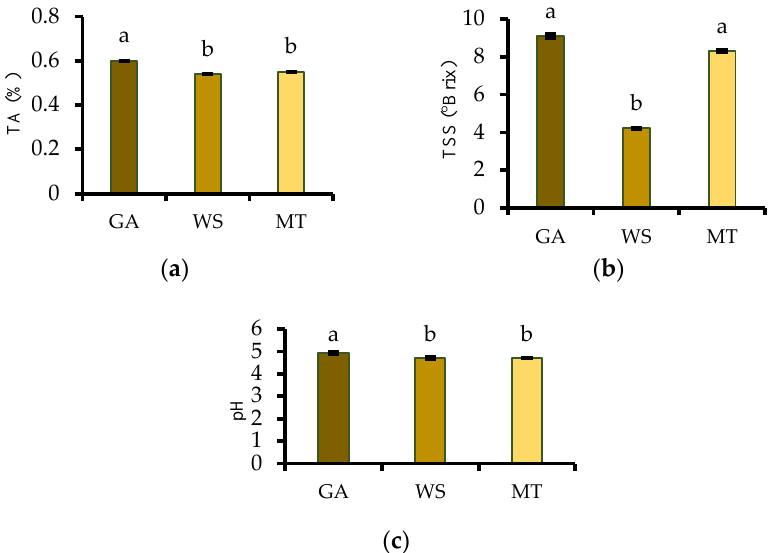
Figure 2. ( a ) TA (titratable acidity), ( b ) TSS (total soluble solids), and ( c ) pH of freeze-dried passion fruit peel powders. Different letters on each bar indicate significant differences in the means ( p < 0.05). Vertical bars on each column graph indicate the standard deviation of the mean. WS = waxy starch; GA = gum arabic; and MT = maltodextrin. Table 2. Techno-functional properties of passion fruit peel freeze-dried powders obtained with MT, WS, and GA as carriers.